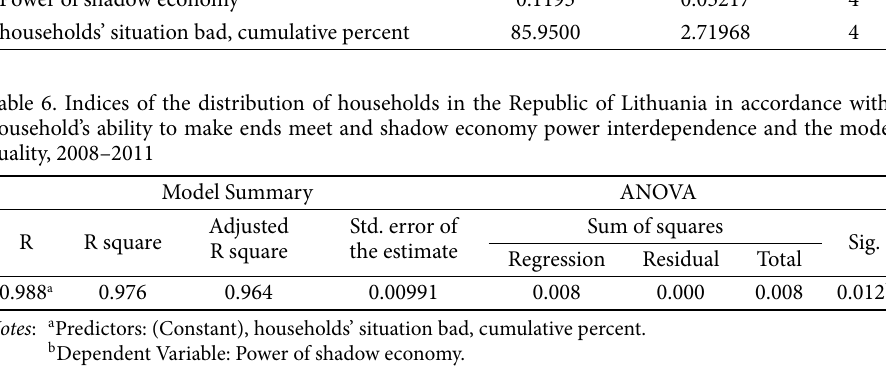
Table 7. Coefficients of the distribution of households in the Republic of Lithuania in accordance with a household’s ability to make ends meet and shadow economy power interdependence, 2008–2011